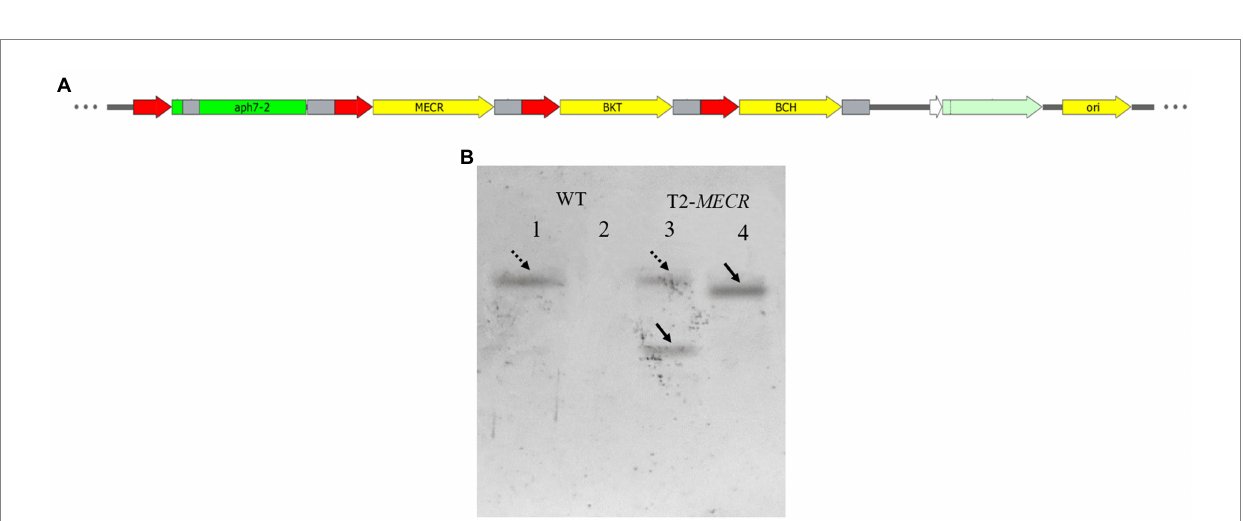
FIGURE 4 The structure of MECR gene expression vector and southern blotting results. (A) Use pHyg3- BKT - BCH as the skeleton, MECR was added. (B) Southern blotting results of MECR in T2. 1–2: WT. 3–4: T2. One and three were digested with Xba I/ Bam HI. Two and Four were digested with Nde I/ Mlu I. The dotted arrows indicate two bands in the same